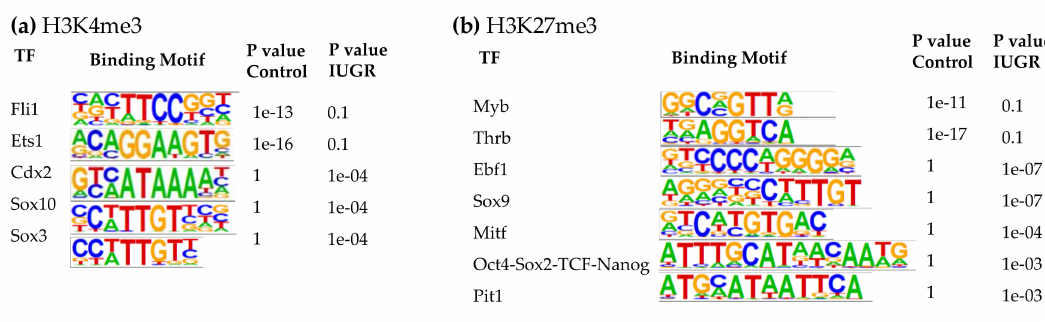
Figure 5. Transcription factor binding motifs enriched in islets at 10 weeks of age. ( a ) H3K4me3; ( b )